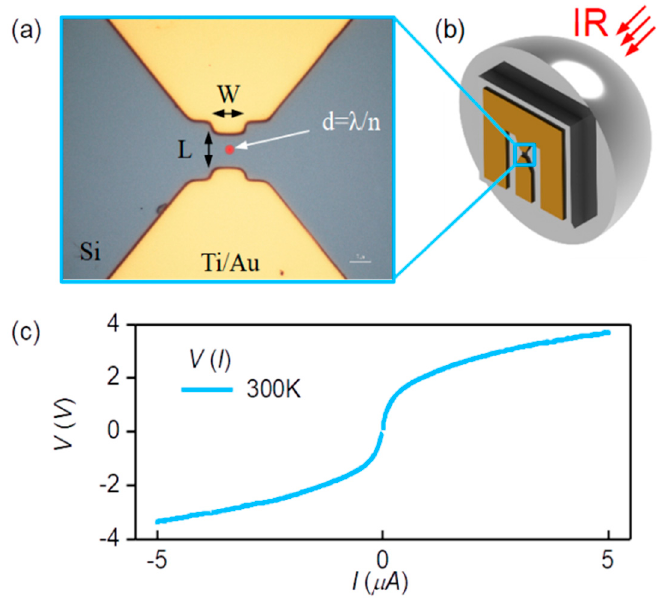
Figure 4. ( a ) An optical image of the inner part of the device; infrared (IR) radiation is focused on the Si surface between the Ti / Au contacts. ( b ) An image of the device mounted on the Si lens. ( c ) An IV curve of the Au / Ti / Si / Ti / Au structure; the shape of the IV curve indicates the formation of a spatial charge distribution at the Si / Ti interface.